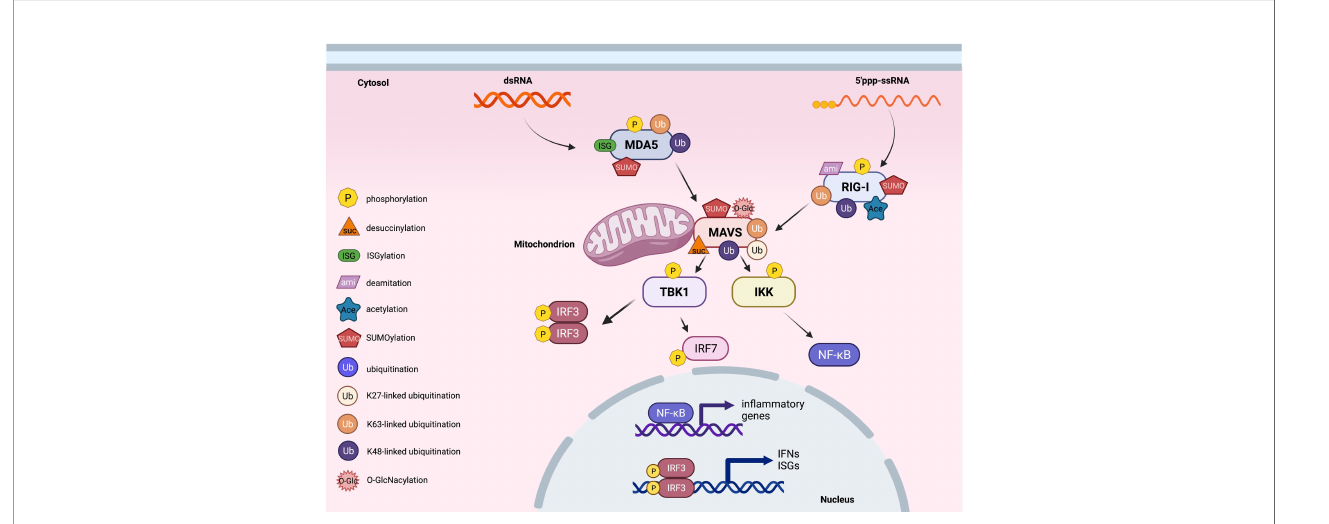
FIGURE 2 | Post-translational modi fi cations of proteins in cytosolic RNA sensing signaling. An overview of cytosolic RNA sensing signaling. Reported post- translational modi fi cations on each RNA sensing signaling pathway member are earmarked by indicated icons. The cartoon illustration is generated by